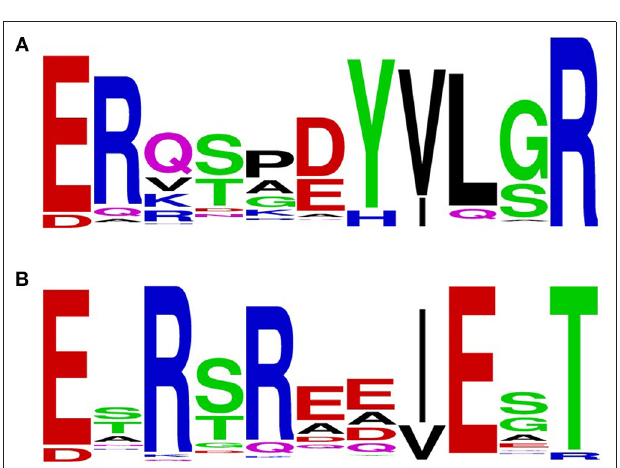
FIGURE 3 | Sequence logos were generated from the aligned sequence parts of PHBHs involved in pyridine nucleotide coenzyme binding using the WebLogo server (ver. 2.8.2, Crooks et al., 2004). (A) Sequence logo generated with the NADPH-specific PHBH Pf as BlastP query input; (B) Sequence logo generated with the NADH-preferring PHBH Ro as BlastP query